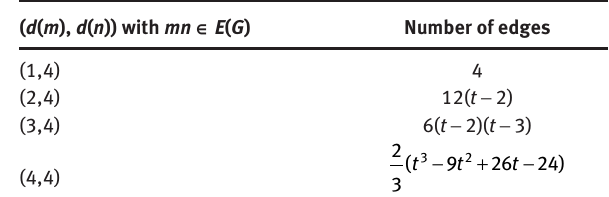
Figure 2: The graph of 5-dimension tetrahedral diamond lattice.